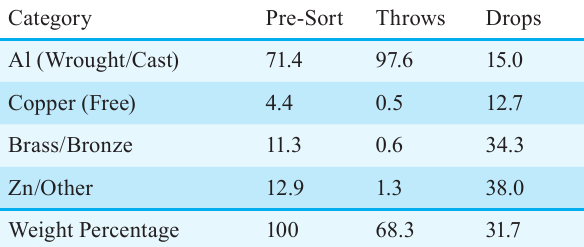
Table 1 Percent composition of Zorba before and after